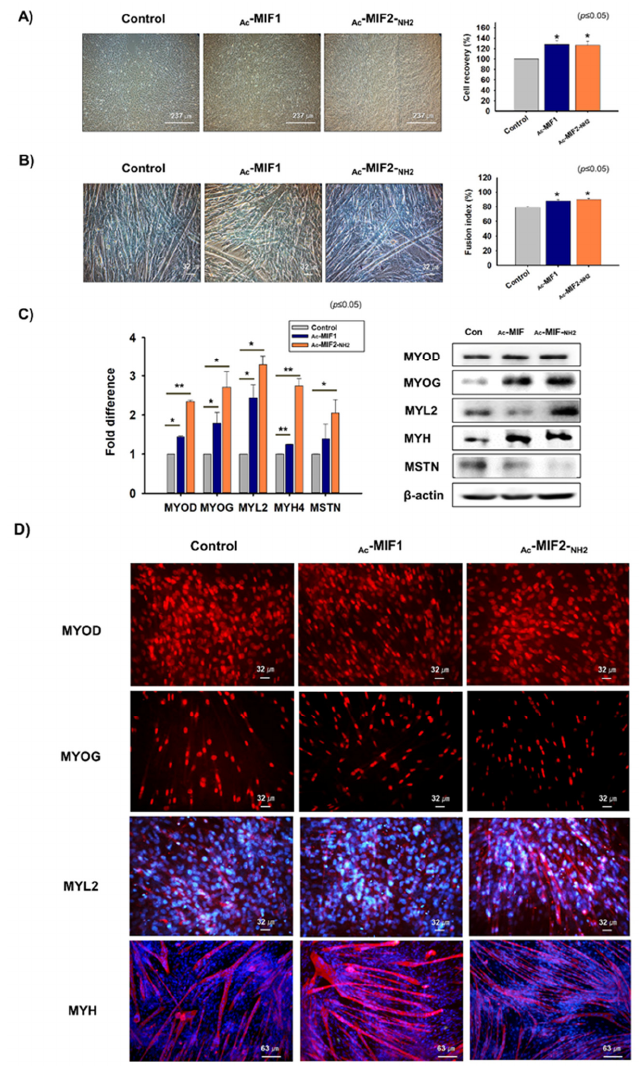
Figure 4. Myoblast proliferation and differentiation with Ac -MIF1 & Ac -MIF2- NH2 peptides. ( A ) When the C2C12 cells reached 100% confluence, layers were scratched and cells were incubated in growth medium supplemented with Ac -MIF1 or Ac -MIF2- NH2 for 1 day. Cell recoveries were analyzed by measuring recovery distances. ( B – D ) When cells reached 70% confluence, growth medium was switched to myogenic differentiation medium and cells were incubated with Ac -MIF1 or Ac -MIF2- NH2 for 3 days. Myotube formation was observed and fusion indices determined by Giemsa staining. mRNA and protein expression of MYOD, MYOG, MYL2, MYH, and MSTN were deter- mined by real-time RT-PCR and Western blot, respectively. Protein localizations were determined by immunocytochemistry. Non-treated cells were used as controls. Means ± SD ( n ≤ 3). * p ≤ 0.05, ** p ≤ 0.001, *** p ≤